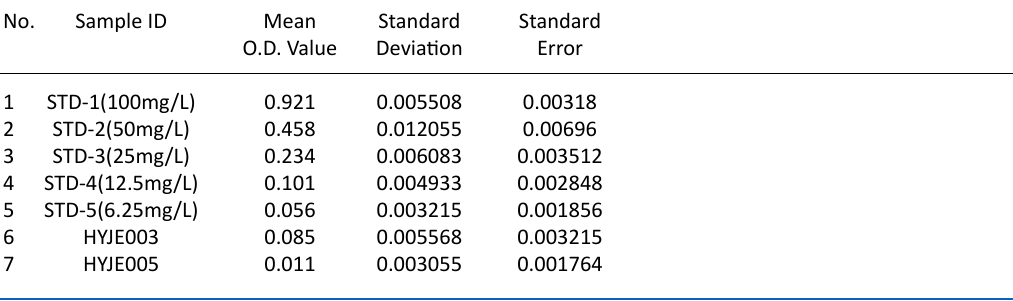
Table 4. Spectrophotometer reading for betaine estimation